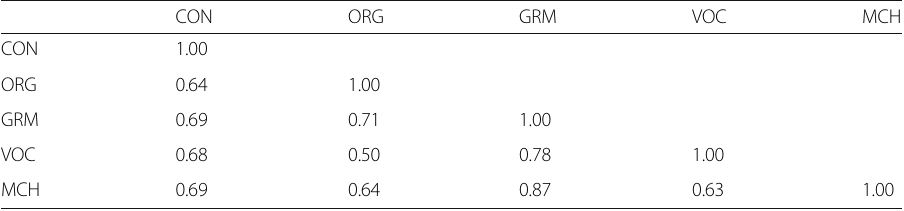
Table 9 Tetrachoric correlations between the